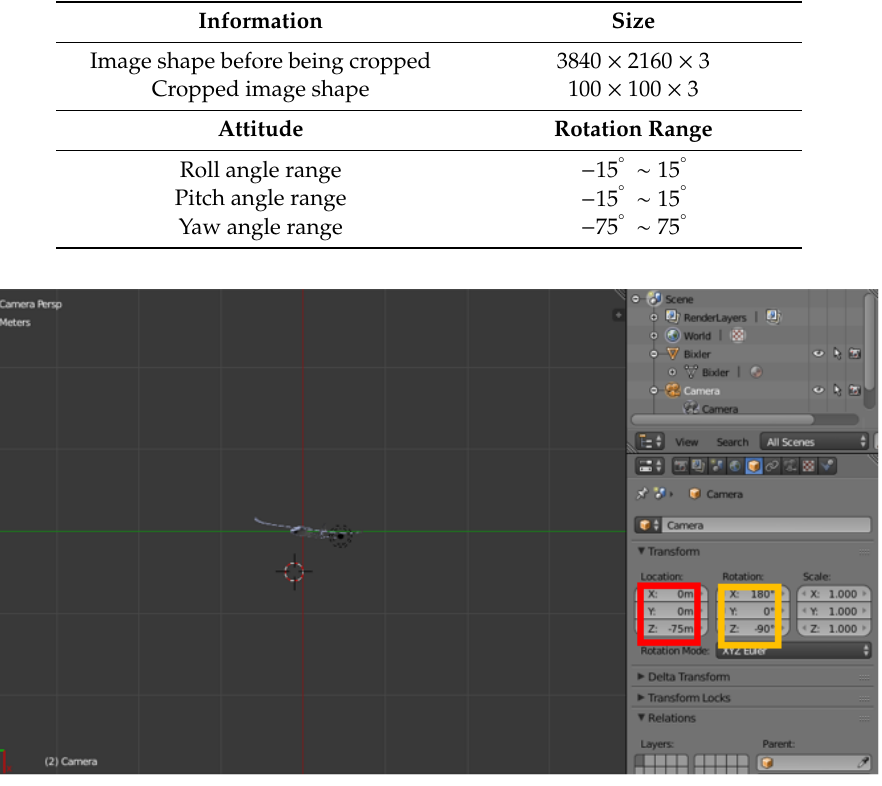
Table 1. Information regarding the training dataset.